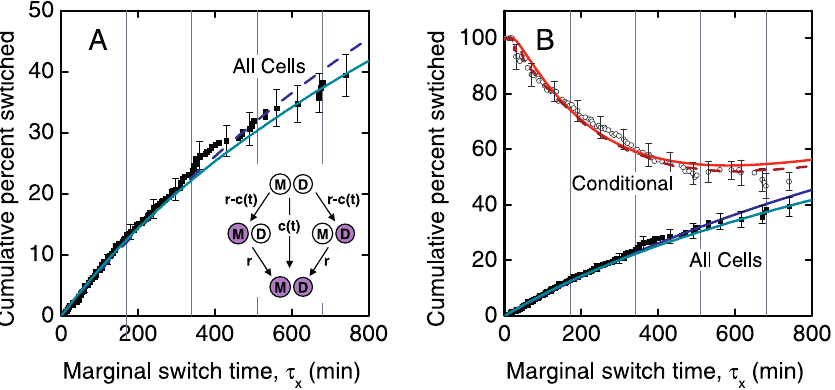
Figure 3. Single-Cell Fate (A) The cumulative percentage of cells that have switched is plotted against their marginal switch time. The black squares represent 251 switching cells, and the blue line is an exponential fit. The cyan dashed line is a result of our stochastic simulation (see Figure 5). Error bars are derived from a bootstrap analysis. The fits are consistent with the idea that a constant-rate process may underlie the network. The inset shows ways that mother-daughter pairs may switch, either dependently via the center route or independently of one another via the outer routes. (B) Gray circles describe the likelihood that a mother cell has switched given that its daughter cell is known to have switched before this time. The solid red line describes a two-parameter least-squares fit simultaneously to both curves with parameters described in the inset and main text. The dashed dark red line shows the fit resulting from the stochastic simulation. Black squares and blue lines are reproduced from (A) for comparison.